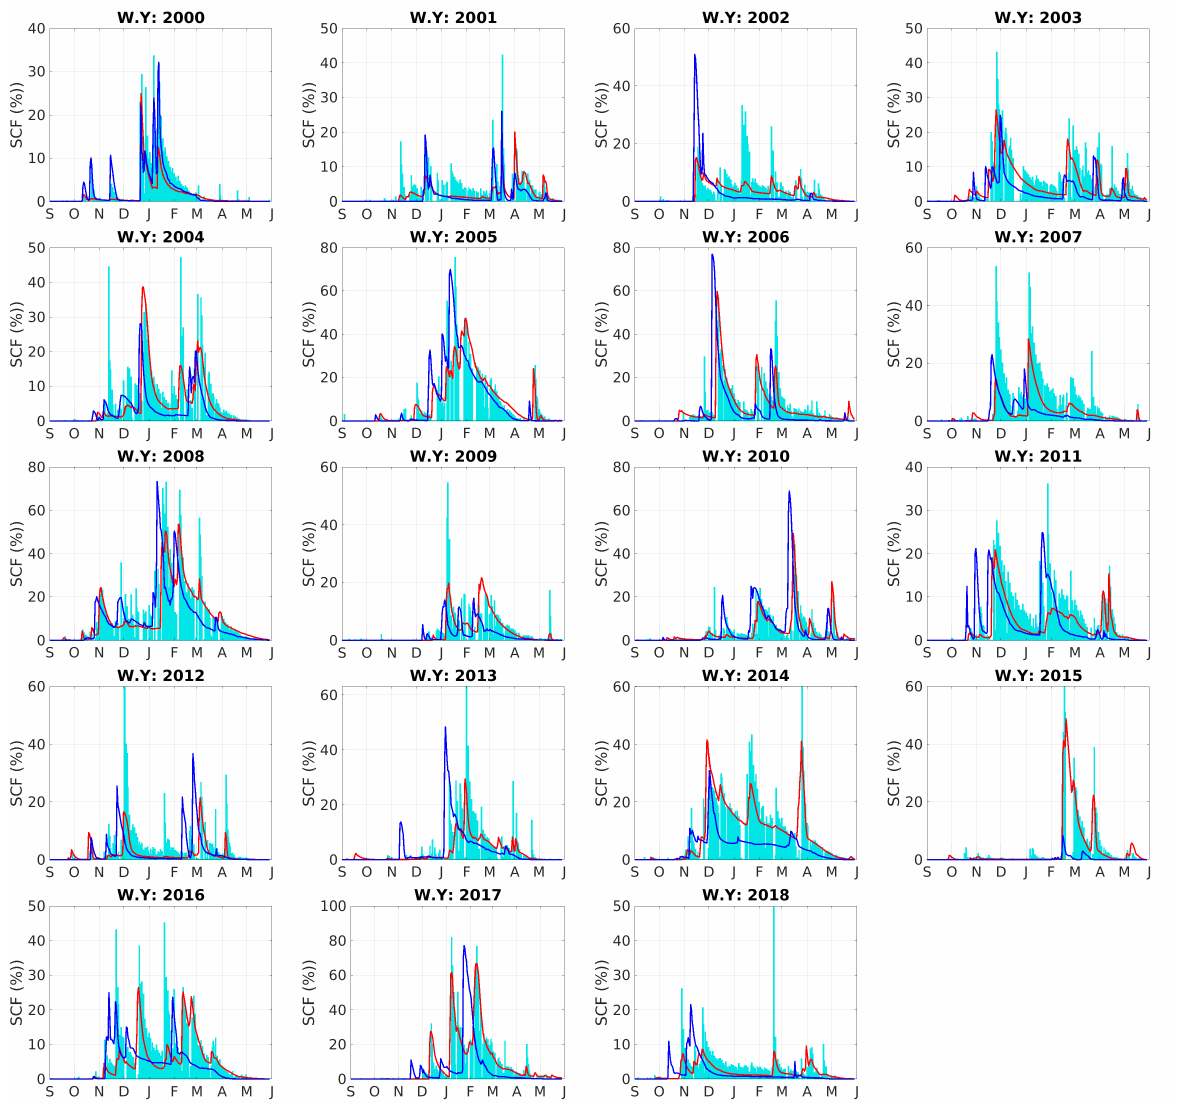
Figure 4. Comparison of total daily snow cover area (km 2 ) at Tensift catchment. The blue curves represent ERA5 modeled SCF, and the red ones represent MERRA-2 modeled